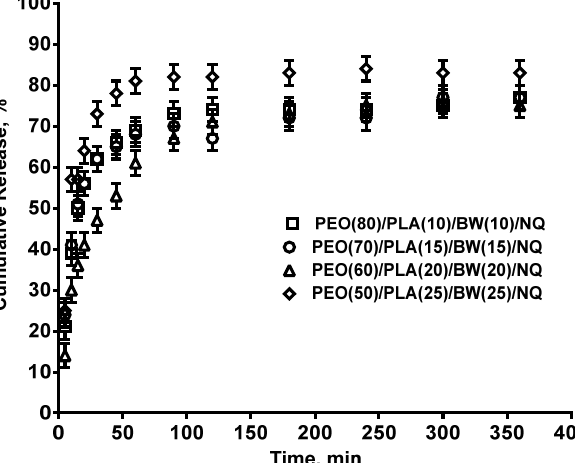
Figure 11. Release profiles of NQ from PEO/PLA/BW/NQ mats using a phosphate buffer solution of pH 7.4 and ionic strength of 0.1 at 37 ºC. Error bars correspond to ± SD values calculated based on three replicates for each time point.